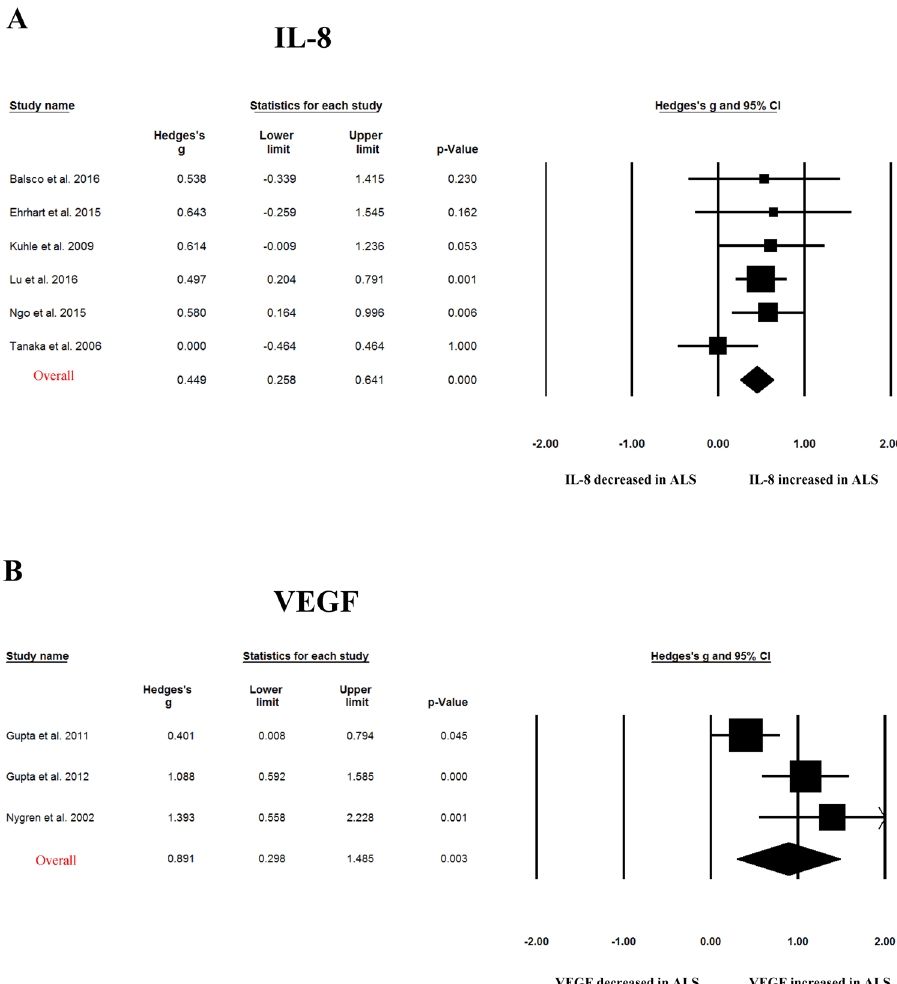
Figure 4. Studies of peripheral blood IL-8 and VEGF. Forest plot displaying random effects meta-analysis results of the association between IL-8 (A) , VEGF (B) and ALS. The sizes of the squares are proportional to study